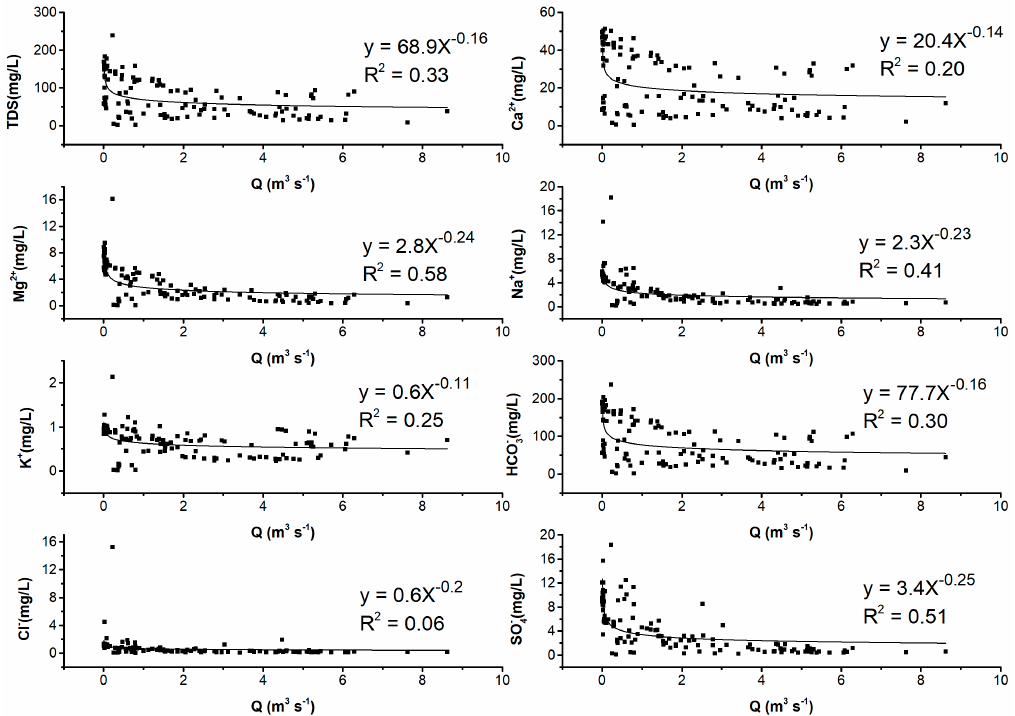
Figure 3. The relationship between major ions and discharge in summer in the Dongkemadi River.